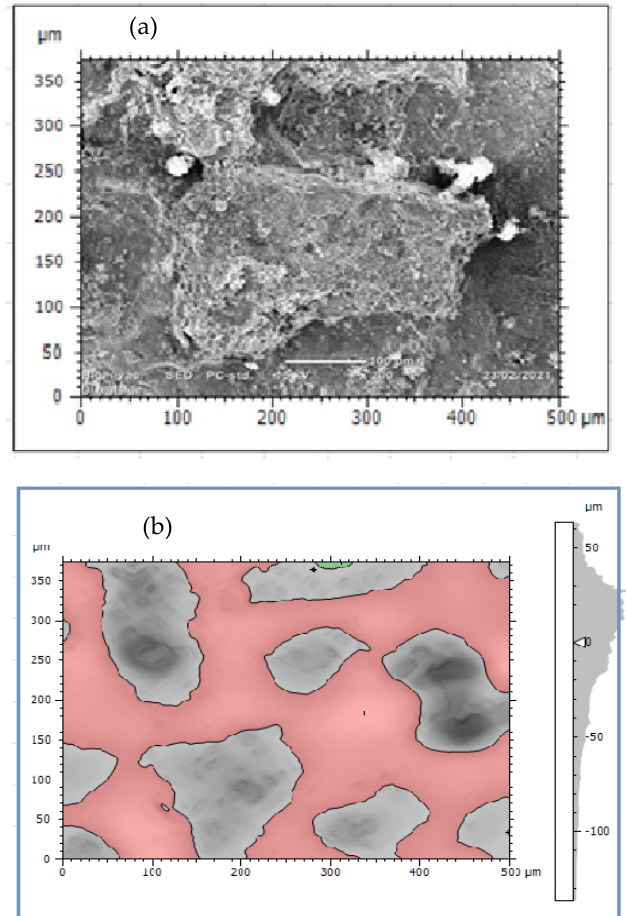
Figure 5. External corrosion damaged surface of DIP: ( a ) True color of SEM image and ( b ) Corrosion scale morphologies.